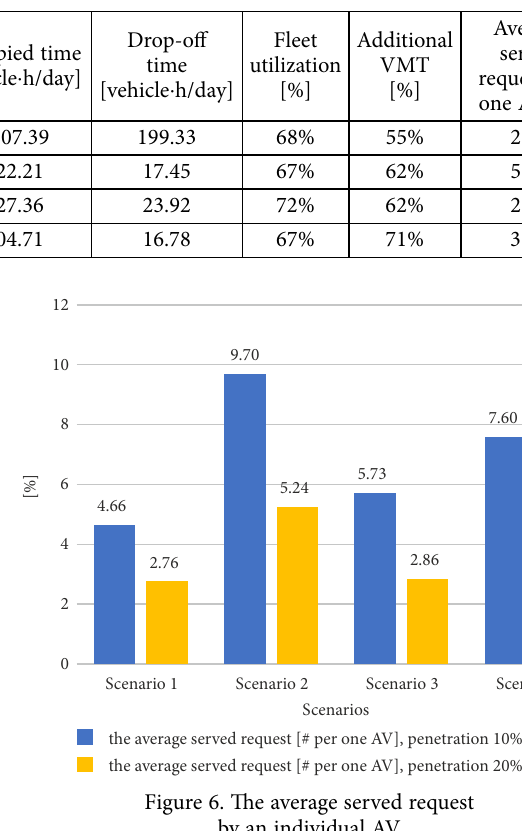
Figure 5. Fleet utilization differences across Figure 6. The average served request